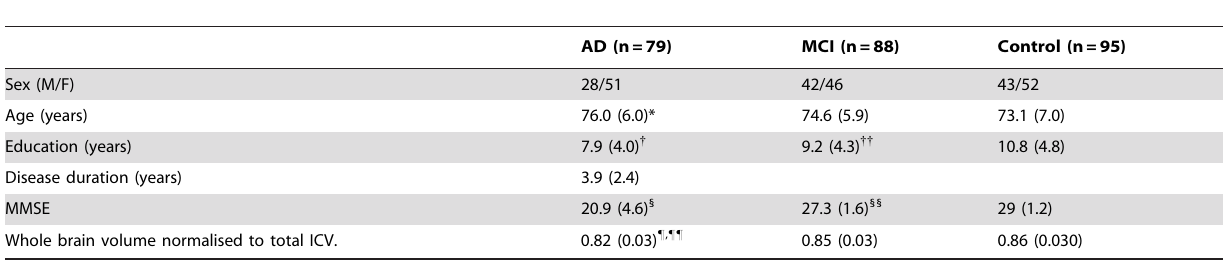
Table 1. Sample characteristics of AD, MCI and control participants in this study.